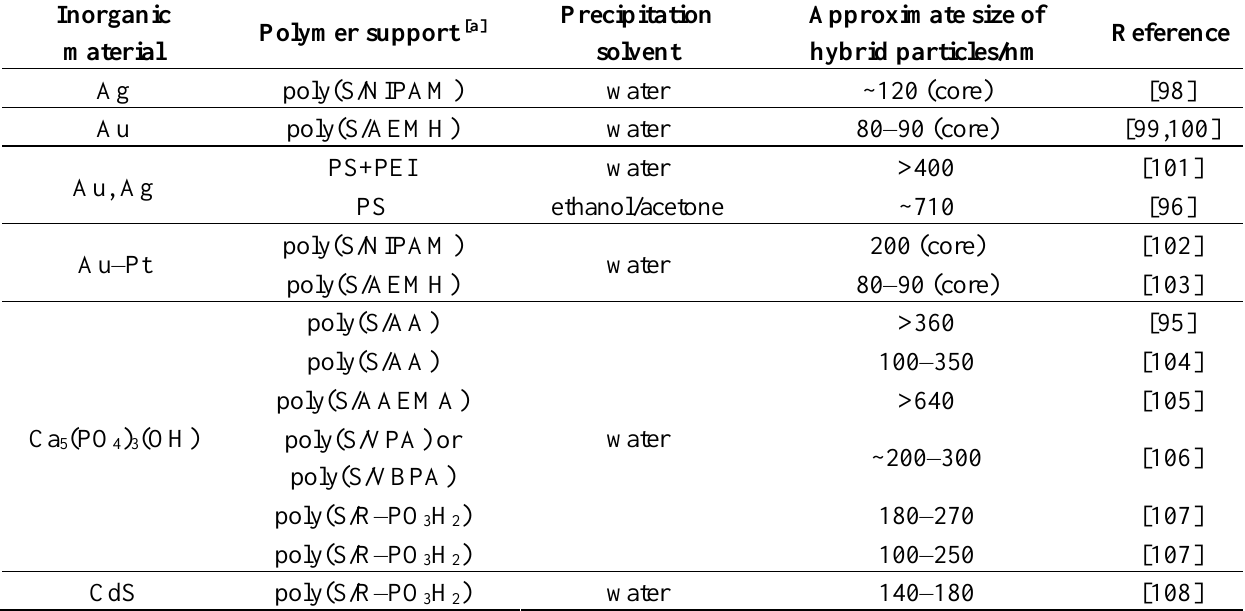
Table 2. Representative works on the formation of polymer/inorganic hybrid particles by in situ precipitation of inorganic materials on the surface of colloid polymer